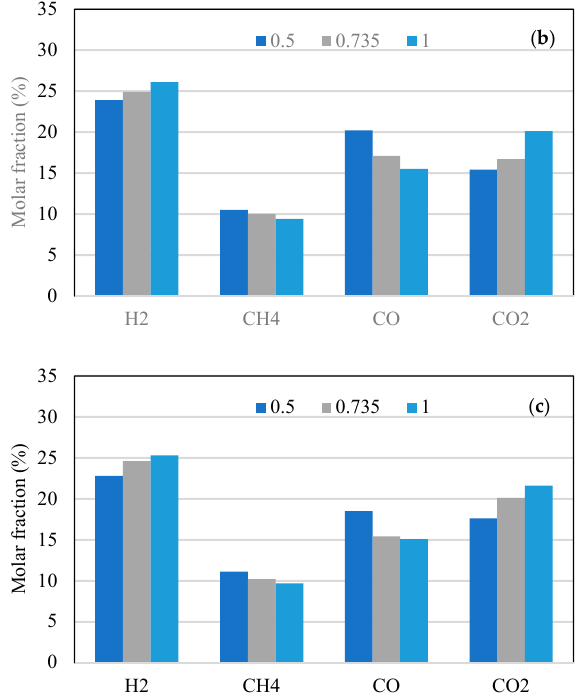
Figure 7. Effect of the steam-to-biomass ratio on the produced gas for temperatures of ( a ) 850 °C, ( b ) 800 °C, and ( c ) 750 °C.